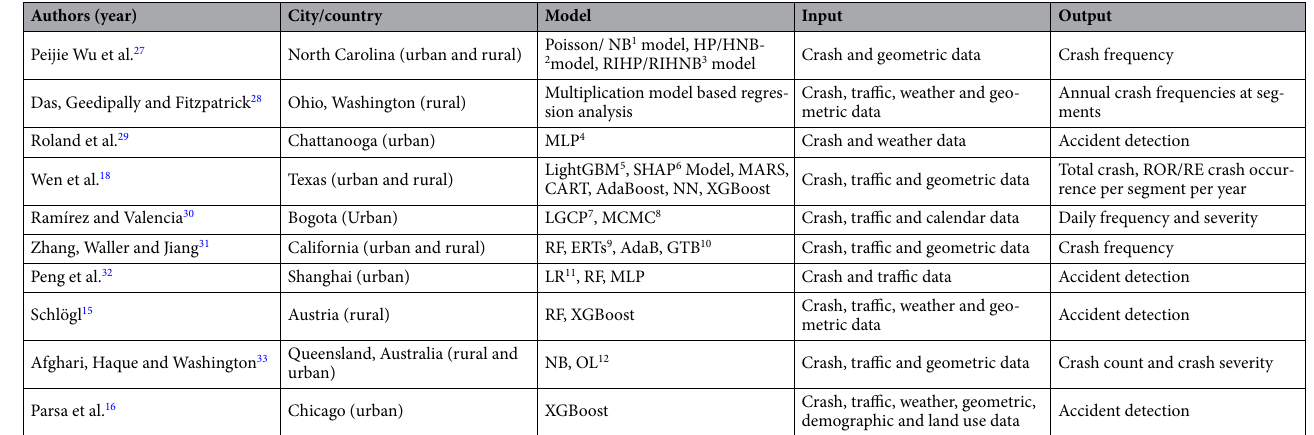
Table 1. Recent studies on crashes analysis and prediction. 1 Negative binomial. 2 Poisson hurdle/Negative binomial hurdle. 3 Random intercepts Poisson hurdle/ random intercepts negative binomial hurdle. 4 A multilayer perceptron. 5 Light gradient boosting machine. 6 Shapley Additive exPlanations. 7 Log Gaussian Cox process. 8 Monte Carlo Markov Chain. 9 Extremely randomized trees. 10 Gradient tree boosting. 11 Logestic regression. 12 Ordered